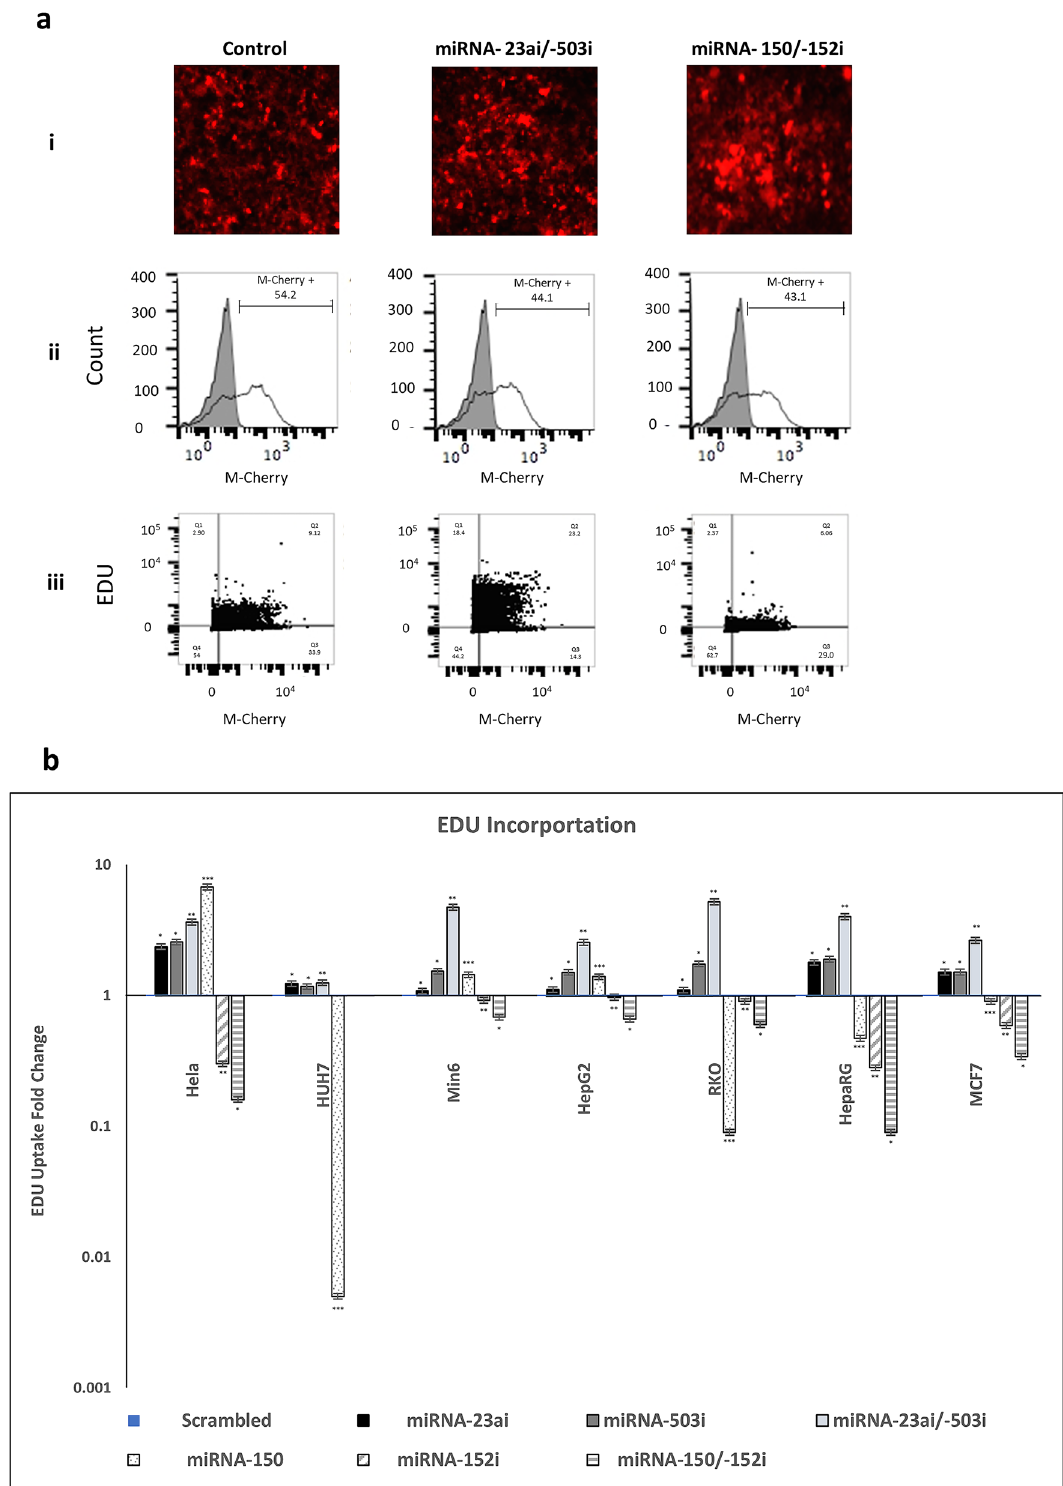
Figure 1. EDU incorporation. ( a ) Expression of miRNA-23ai/-503i and miRNA-150/-152i in HepG2 cancer cell lines under selection pressure. (i): Fluorescence images of samples transduced with scrambled, miRNA-23ai/-503i and miRNA-150/-152i. (ii): Flow cytometry profiles showing transduced HepG2 cells compared to un-transduced cells. All constructs co-expressed MCherry; bar represents the proportion of positively transduced cells. (iii): Flow cytometry dot plots showing EdU incorporation in HepG2 cells transfected with scrambled, miRNA-23ai/-503i and miRNA-150/-152i. ( b ) EdU uptake and fold change in Hela, HUH7, Min6, HepG2, RKO, HepaRG and MCF7 cell lines transduced with scrambled, miRNA-23ai, miRNA-503i, miRNA-23ai/-503i, miRNA-150, miRNA-152i and miRNA- 150/-152i. The fold change of EDU + /M-Cherry + cells in each cell line are compared against scrambled control vector. Results are representative of three independent experiments. Error bars indicate SD. *p < 0.05,** p < 0.01, ***p <